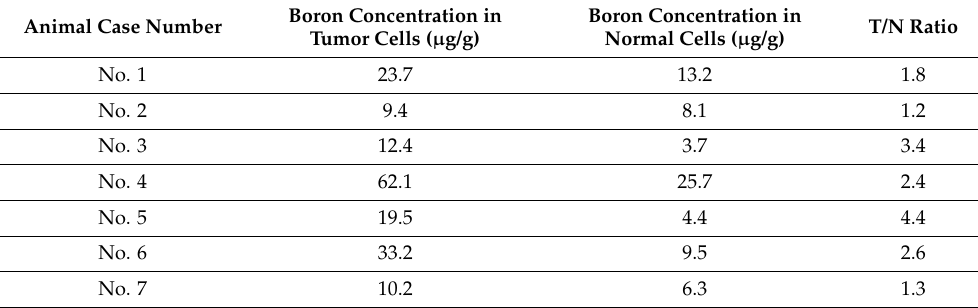
Table 3. Results of boron uptake into normal brain cells and tumor cells by the boron CSF admin- istration method (Nos. 1–5) and by the IV administration method (Nos. 6 and 7) in B16F10 mela- noma model rats.